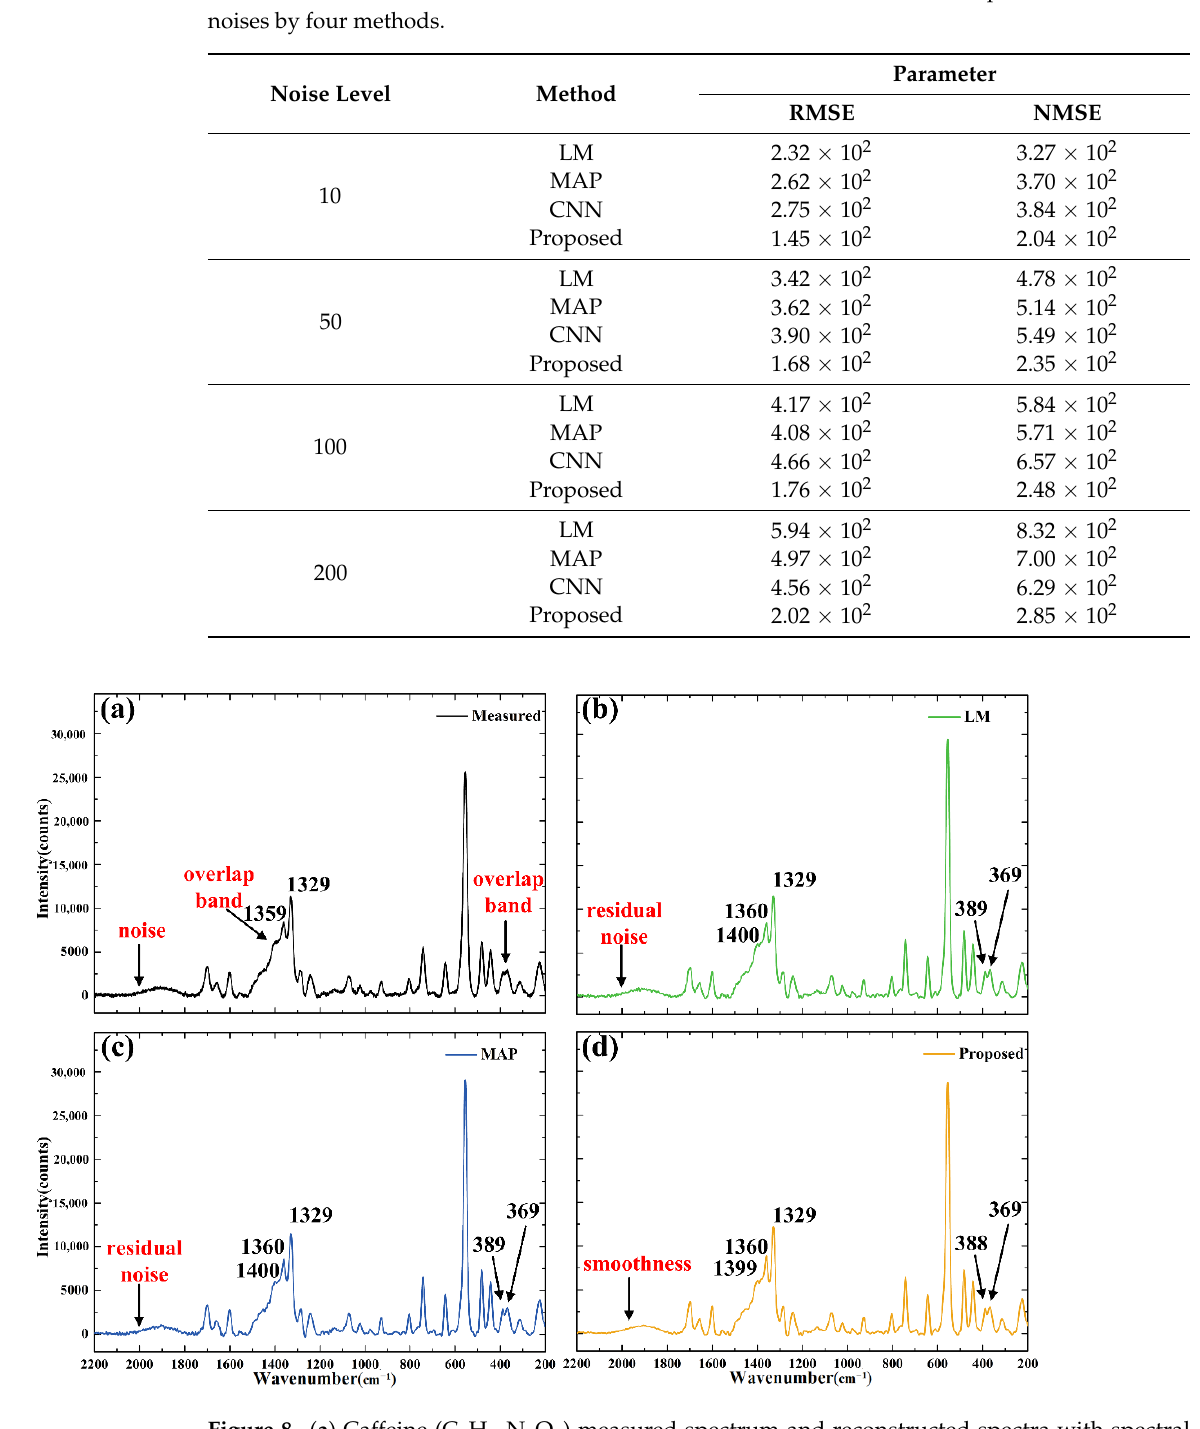
Figure 9. ( a ) Ketamine (C 13 H 16 ClNO) measured spectrum and reconstructed spectra with spectral range from 2200 to 200 cm −1 by ( b ) the LM method; ( c ) the MAP method; ( d ) the proposed method.